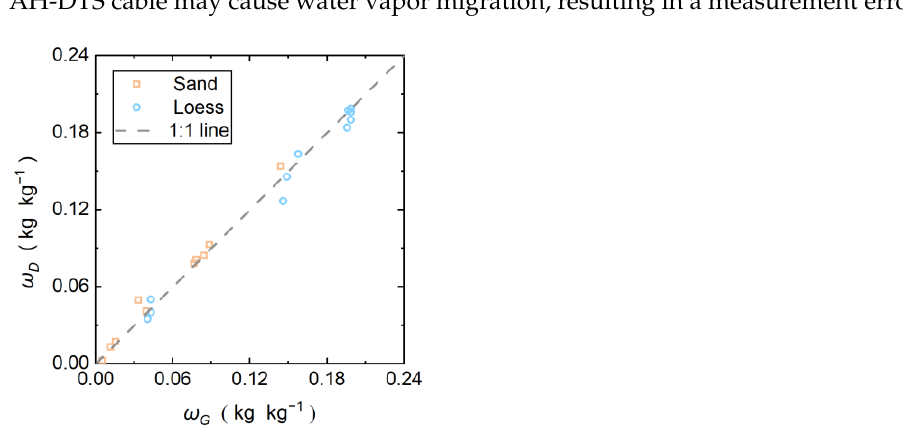
Figure 8. Comparison of the soil moisture in sand and loess estimated by DPHP-DTS method ( ω D ) and oven drying method ( ω G ). and oven drying method ( ω G